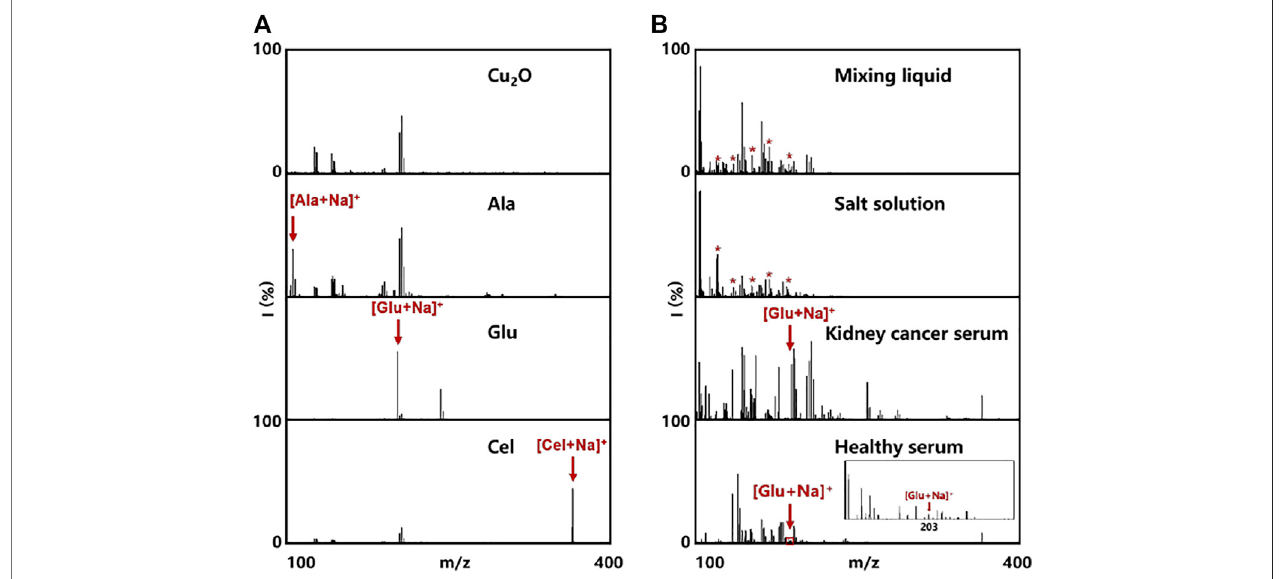
FIGURE 3 | Cu 2 O NPs assisted LDI MS for analysis of (A) Cu 2 O NPs as control and some small metabolites (500 nL, 7 mM for each). (B) mixing liquid of alanine, leucine, aspartic acid, arginine, and glucose in water and salt solution, as well as metabolic fi ngerprinting of serum (500 nL) from healthy control and kidney cancer patient. The red asterisks represent alanine, leucine, aspartic acid, arginine, and glucose at the m/z peaks of 127, 154, 178, 199, and 203, respectively.